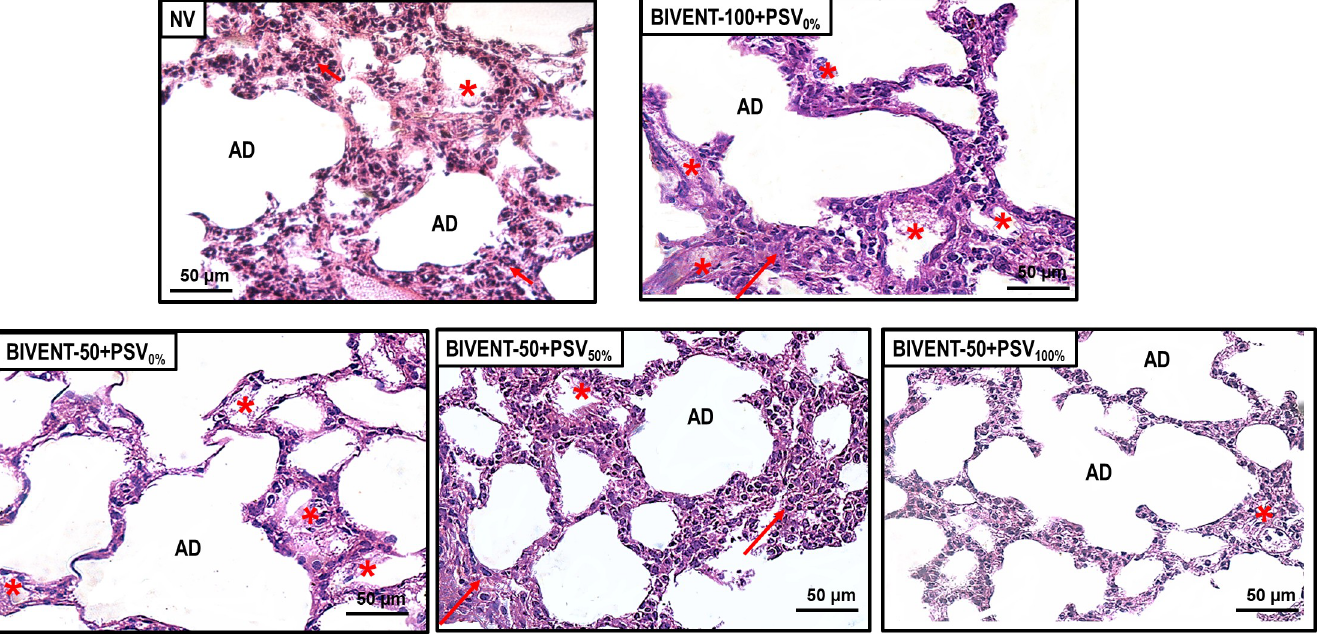
Fig 3. Representative photomicrographs of lung parenchyma stained with hematoxylin–eosin. NV (nonventilated), BIVENT-100+PSV 0% and BIVENT-50+PSV 0% : The frequency of control breaths is 100 and 50 breaths/min, respectively. BIVENT-50+PSV 50% : PSV set to half the value of P high (PSV 50% ). BIVENT-50+PSV 100% : PSV equal to the value at P high (PSV 100% ). Note the preserved microscopic architecture of the lung parenchyma in BIVENT-50+PSV 50% animals. AD: Alveolar duct. Asterisk: Interstitial edema. Arrows: Areas of alveolar collapse. Scale bar = 50 μ